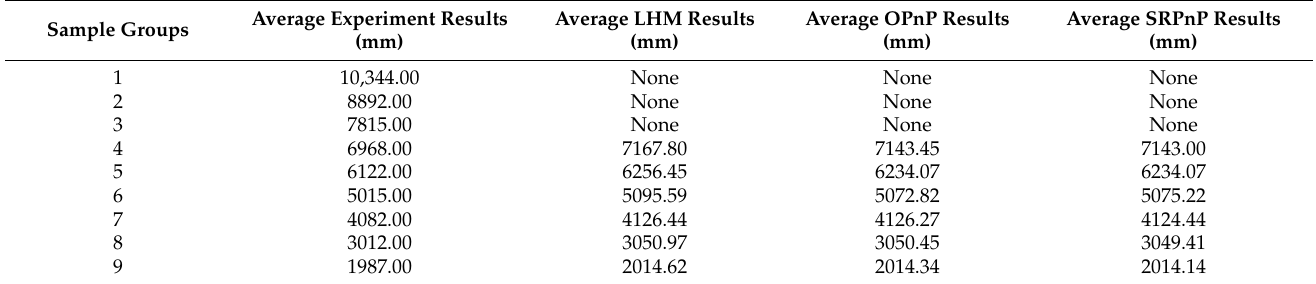
Figure 17. Traditional PnP algorithm distance detection results: ( a ) Detection results of optical beacons within 7 m; ( b ) Detection results of optical beacons within 6 m; ( c ) Detection results of optical beacons within 5 m; ( d ) The average relative error of translation. Table 1. Experimental data and algorithm detection results.